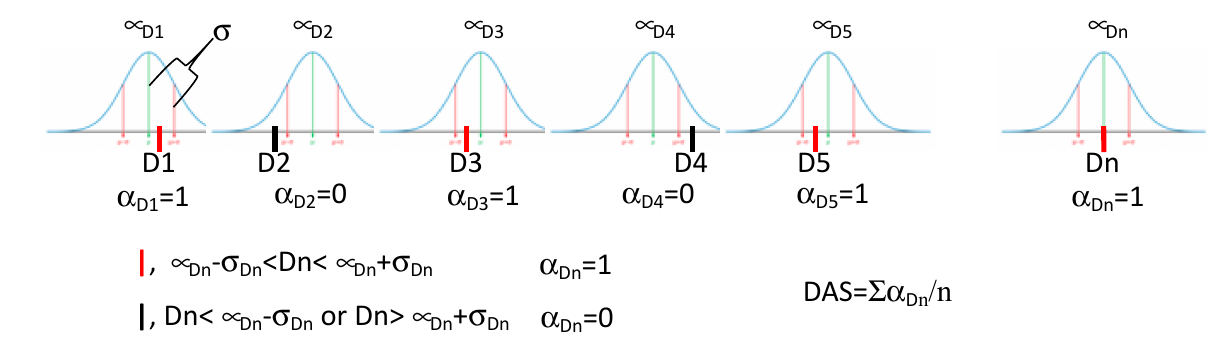
Figure 5. DAS (DRUDIT affinity score) calculation: D1, D2, . . . , Dn: molecular descriptor values for the input structure; n: number of molecular descriptors.